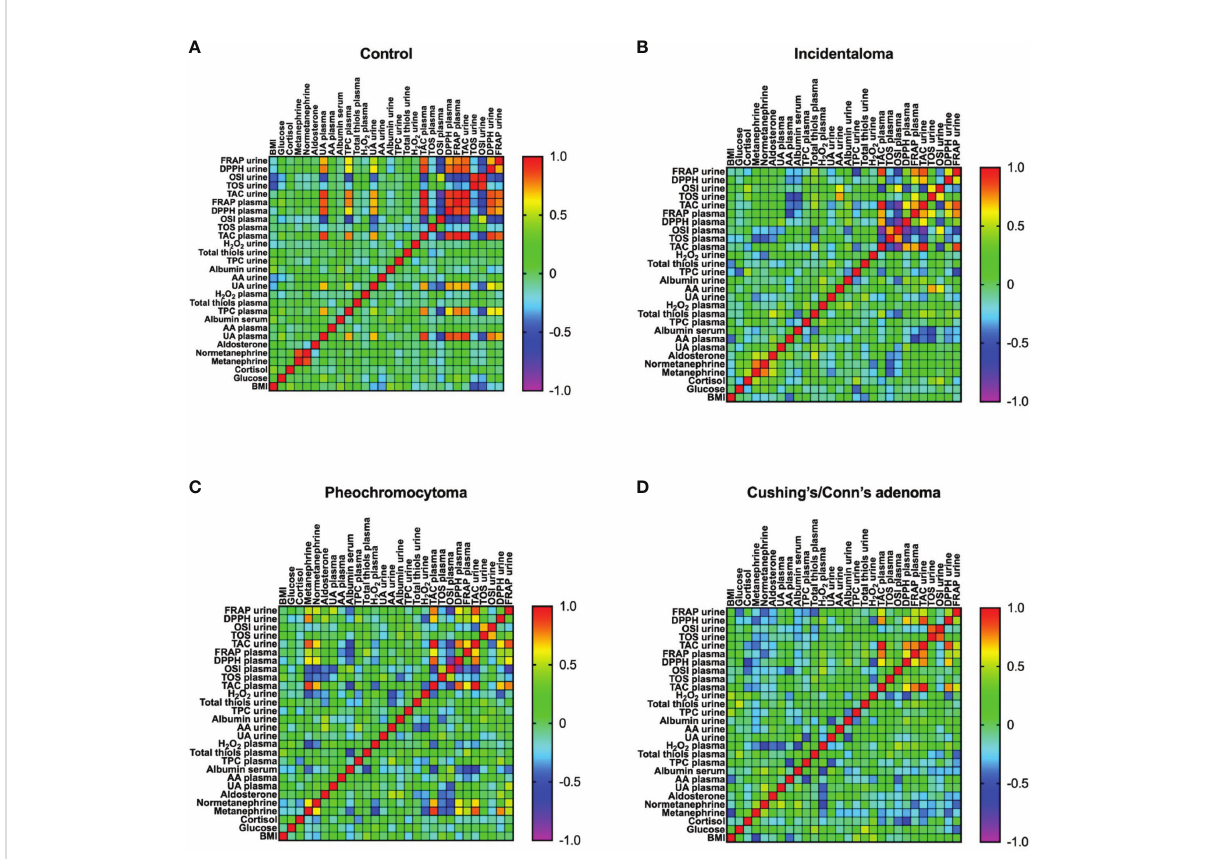
FIGURE 3 Correlations between the analyzed redox biomarkers and clinical parameters in in plasma and urine of the controls (A) and patients with incidentaloma (B) , pheochromocytoma (C) , and Cushing ’ s/Conn ’ s adenoma (D) . Ferric reducing antioxidant power (FRAP), 2,2 ′ -diphenyl-1- picrylhydrazyl radical (DPPH), oxidative status index (OSI), total oxidant status (TOS), total antioxidant capacity (TAC), body mass index